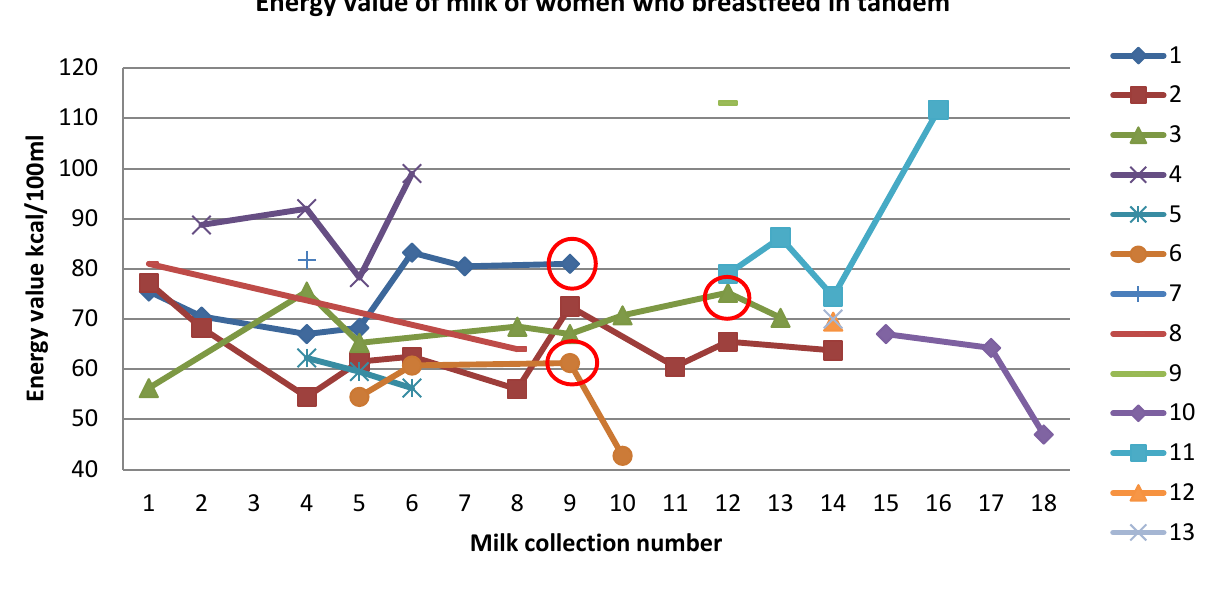
Chart 4. Individual changes in energy value. The weaning time is indicated by the red circle, 1–10 monthly milk collection. tion. No statistically significant difference ( p < 0.05) in the content of macronutrients was observed between milk samples obtained in 4 time intervals during the 24 h period. Changes in the content of individual nutrients during lactation are presented in Charts